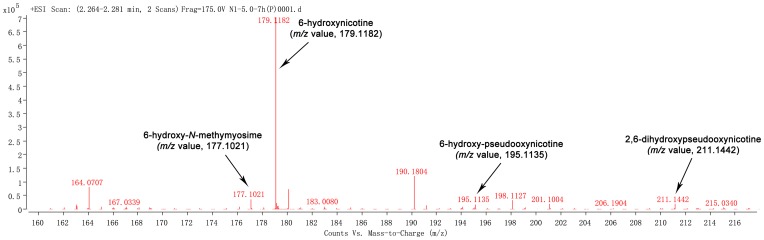
ESI-TOF-MS analysis of the metabolites of nicotine degradation by strain N1.ESI-TOF-MS analysis of the intermediates of nicotine degradation by “resting cell reactions” of strain P. geniculata N1. The molecular ion peaks ([M+H]+) of 6-hydroxynicotine (6HN, C10H14N2O), 6-hydroxy-N-methymyosime (6HMM, C10H12N2O), 6-hydroxy-pseudooxynicotine (6HPON, C10H14N2O2), and 2,6-dihydroxypseudooxynicotine (2,6HPON, C10H14N2O3), were shown at m/z 179.1182, 177.1021, 195.1135, and 211.1442 respectively.